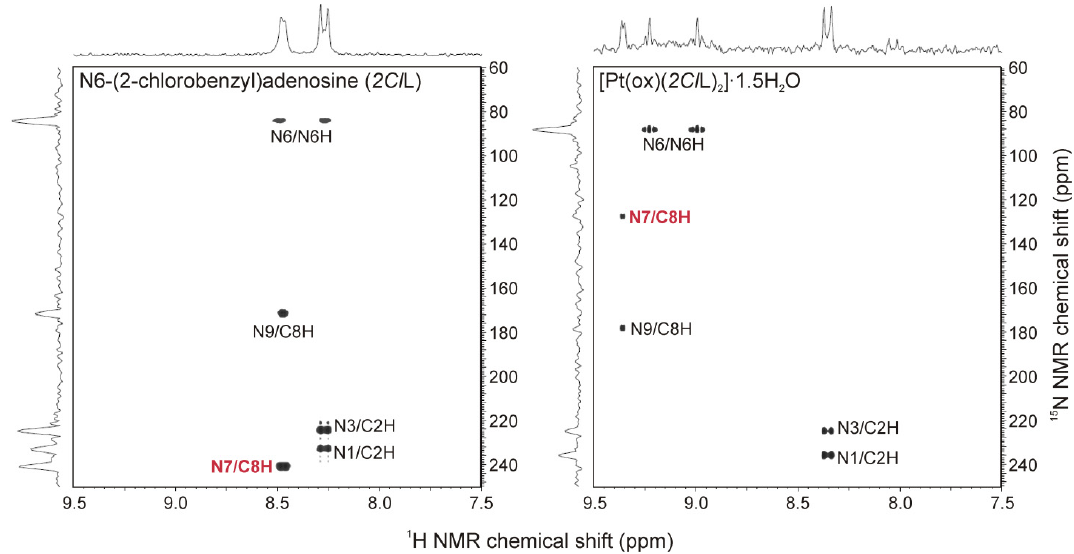
Figure 3. The results of 1 H– 15 N gs-HMBC experiments on N 6-(2-chlorobenzyl)adenosine ( 2Cl L; left ) and the complex 4 ( right ) involving 2Cl L as N7-coordinated ligand, showing